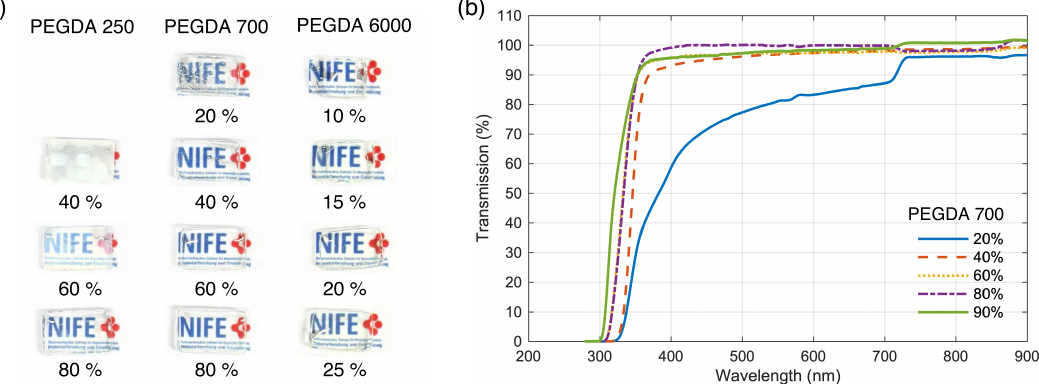
Figure 3. ( a ) Transparency of the hydrogels for different molecular weight and concentration; ( b ) Optical transmission of PEGDA 700 hydrogels for different